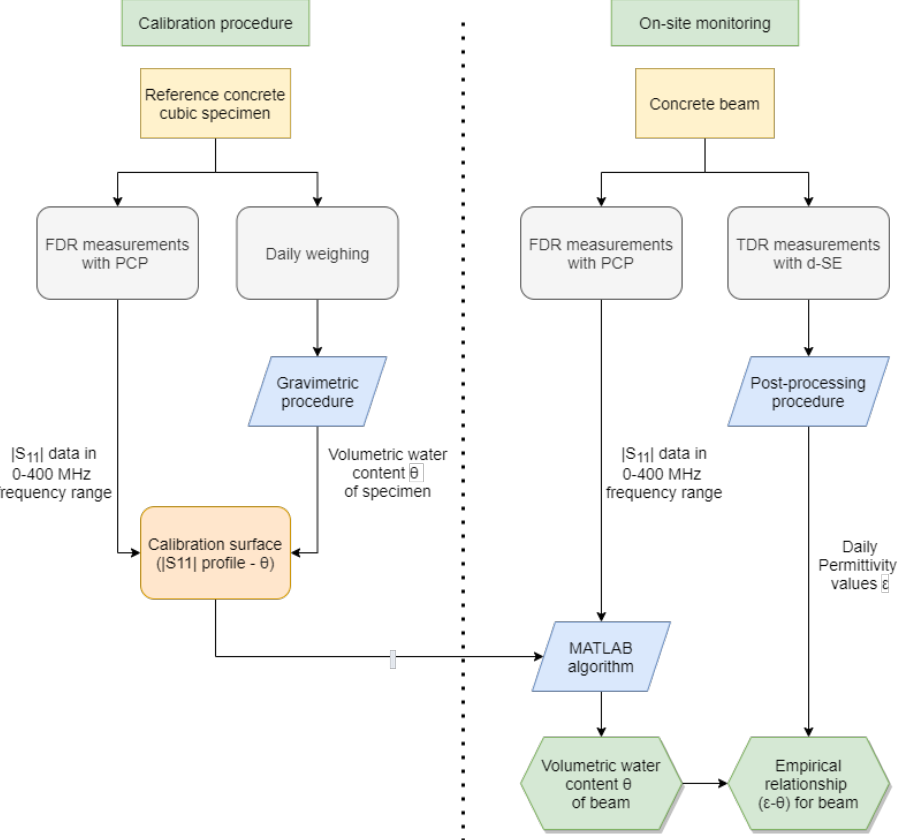
Figure 4. Diagram of the combined monitoring procedure: Preliminary Calibration Procedure ( left ) and procedure for on-site monitoring procedure ( right